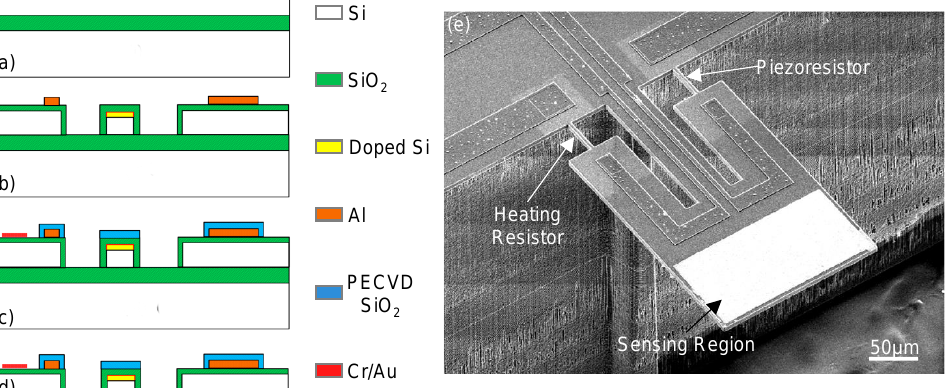
Figure 4. In-plane-mode resonant microcantilever mass sensors. ( a – d ) Fabrication process of micro- cantilevers showing on-chip integration of electrothermal excitation and piezoresistive readout. ( e ) Typical resonant sensor with sensing region for loading functional nanomaterials. Reprinted with permission from [26]. Copyright 2011 Elsevier B.V.